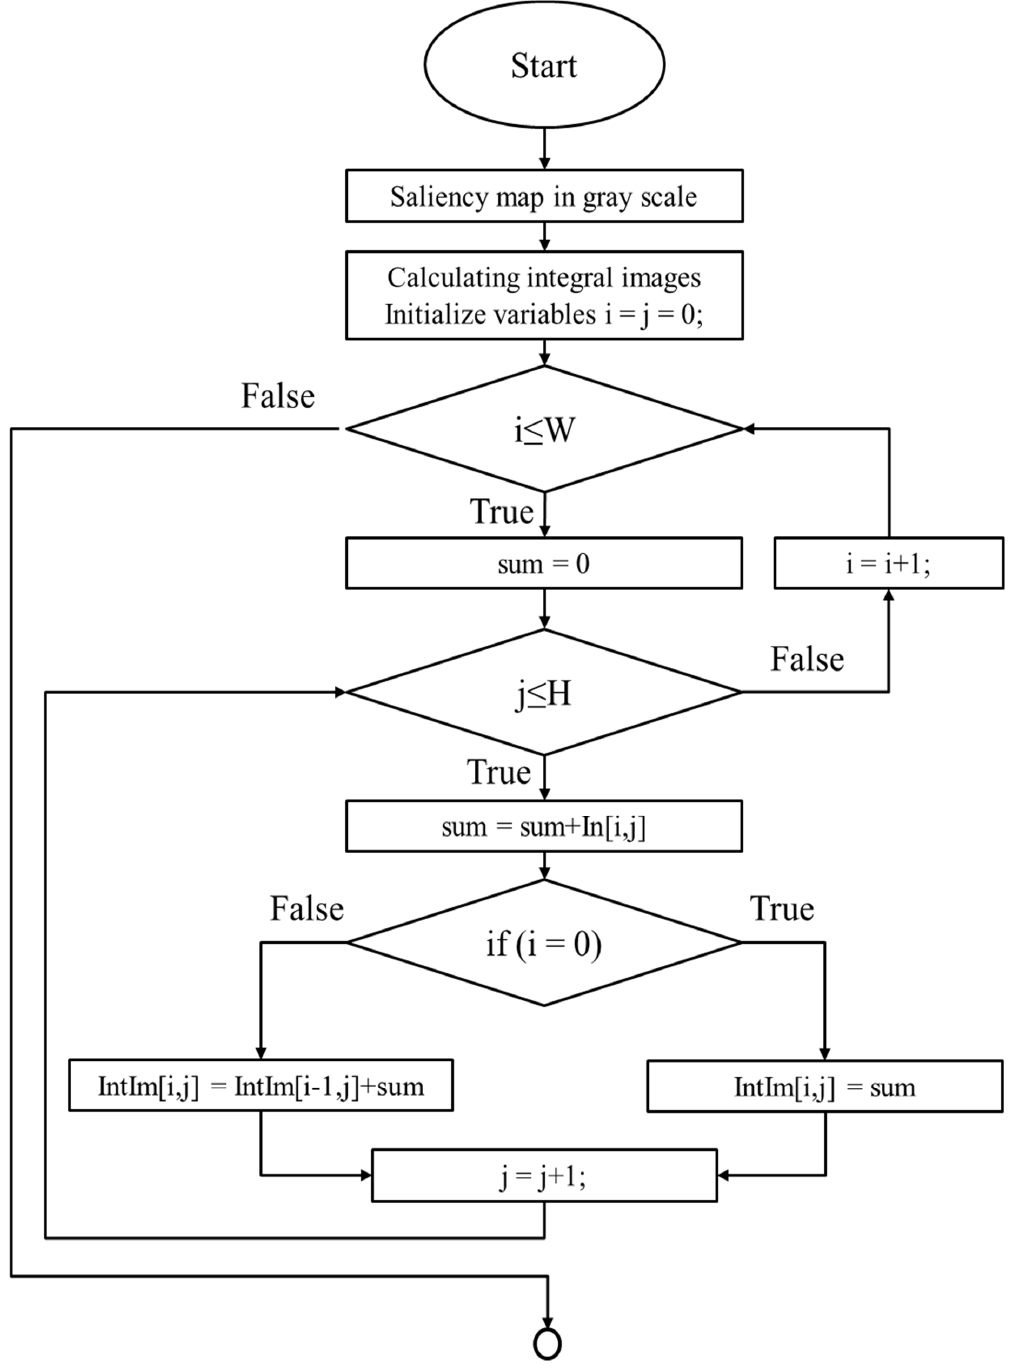
Figure A1. The block diagram of the proposed locally adaptive triple-thresholding using integral images for salient object extraction (one-part).